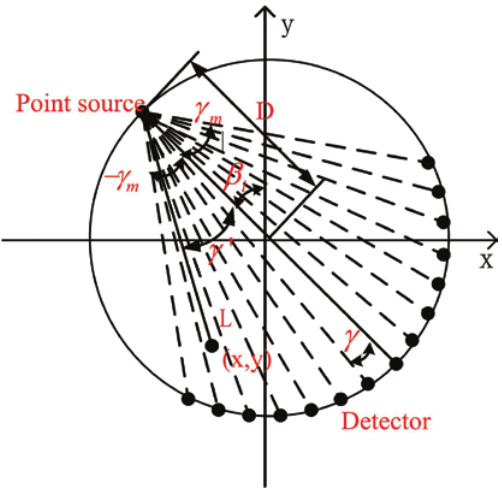
Figure 1: Geometry of the fan-beam technique.